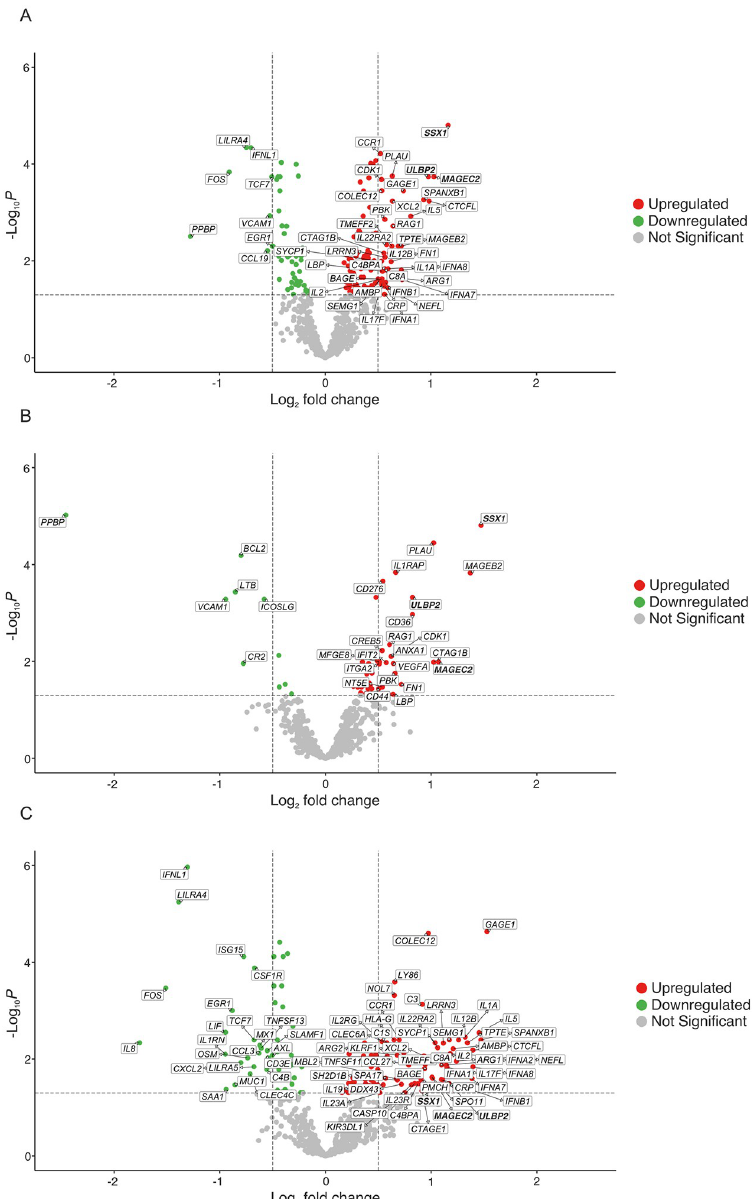
Fig 4. Genes differentially expressed in short survival versus long survival patients, considered according to cancer type and cancer class. Volcano plots showing significantly downregulated (the thresholds are FDR < 0.005; logFC < -0.5) and upregulated (the thresholds are FDR < 0.005; logFC > -0.5) genes in green and red, respectively. Here short survival patients are compared with long survival patients, so in all three panels genes found to be upregulated are genes that are upregulated in short survival patients, and genes found downregulated are genes that are downregulated in short survival patients. Grey indicates genes that are not significantly downregulated or upregulated. Log of fold change (LogFC) is on the x-axis and significance level (-log 10 P) is on the y-axis. Panel A shows differentially expressed genes when all of the patients are considered (n = 515). Panel B shows differentially expressed genes when only patients with solid cancers are considered (n = 293), and panel C shows differentially expressed genes when only patients with blood cancers are considered (n = 222). In all panels, the significantly downregulated and upregulated genes are labelled with their Hugo Gene Nomenclature Committee (HGNC) gene symbols. The three genes (SSX1, MAGEC2 and ULBP2) that are found to be significantly differentially expressed in all three analyses are shown in bold.